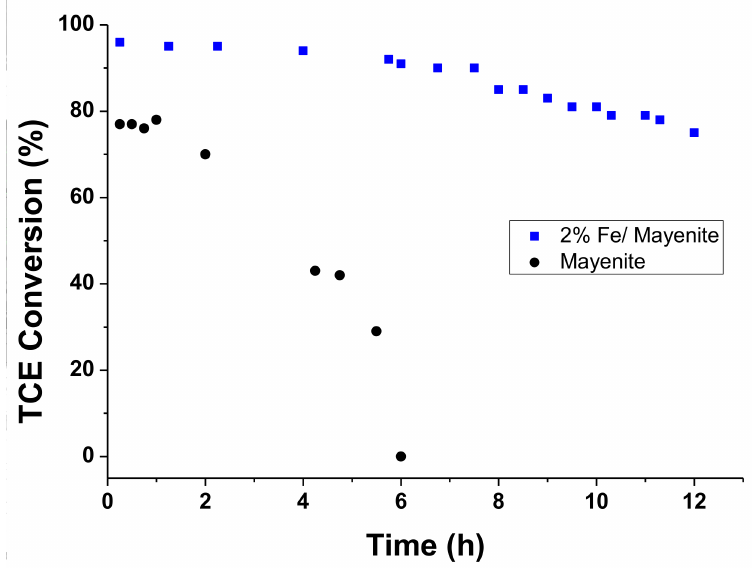
Figure 5. Comparison of catalyst stability (T = 460 ◦ C, 1700 ppm TCE, GHSV = 6000 h − 1 , 0.8 g of